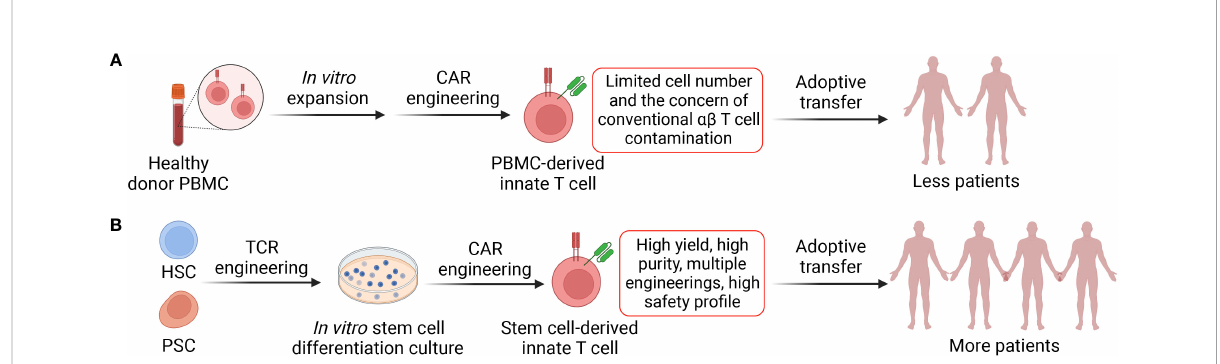
FIGURE 3 Two approaches to generate CAR-engineered innate T cells. (A) Innate T cells are enriched from healthy donor peripheral blood mononuclear cells (PBMCs) via cell sorting, cultured in vitro and engineered with CARs. The generated CAR-engineered innate T cells could target both tumor and immunosuppressive cells. However, these cells have limited expansion fold and yield; therefore, the cell products could be adoptively transferred to less cancer patients. (B) Stem cells such as hematopoietic stem cells (HSCs) and pluripotent stem cells (PSCs; include embryonic stem cells and induced PSCs) could be engineered with innate T cell TCR and then cultured in the in vitro differentiation systems where the stem cells develop into mature innate T cells. The platforms could be easily combined with CAR engineering and other genetic modi fi cations such as CRISPR-Cas9. The stem cell-derived innate T cells have high yield and purity and can be transferred to more cancer